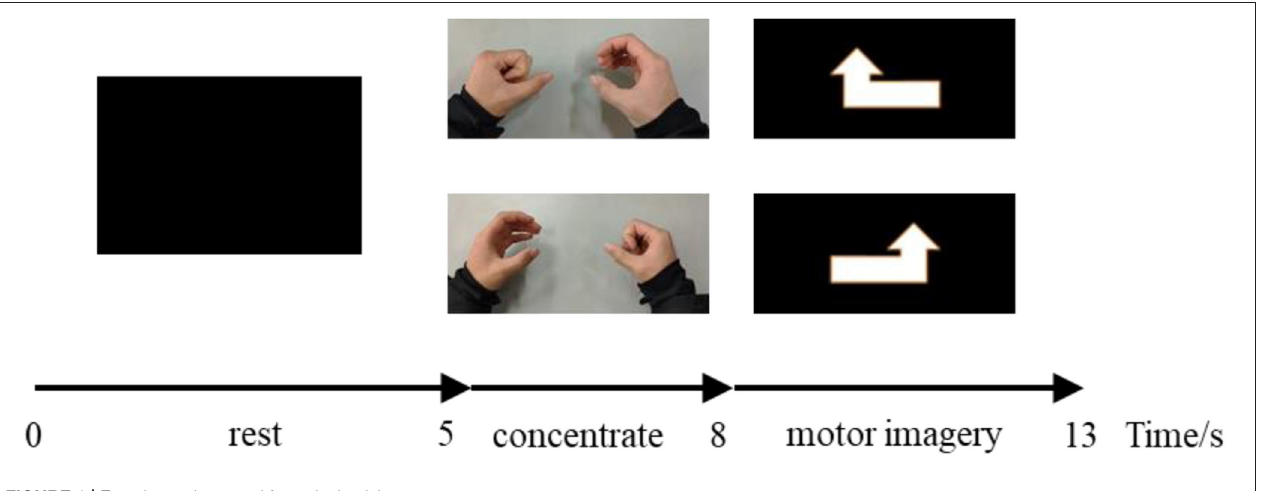
FIGURE 1 | Experimental protocol for a single trial.